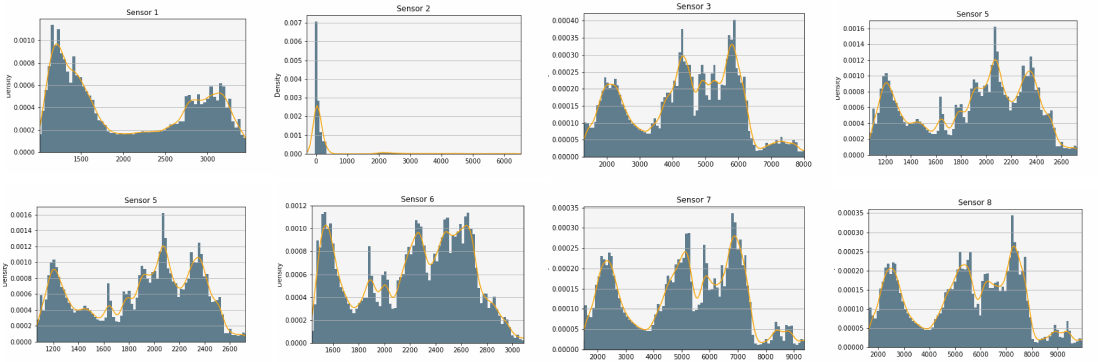
Figure 3. Distribution of the first 8 features in the [39] dataset. Each subplot shows the distribution of a reading of the sensor array. In grey, the histogram of the feature, and in orange a Gaussian kernel estimator of its density.